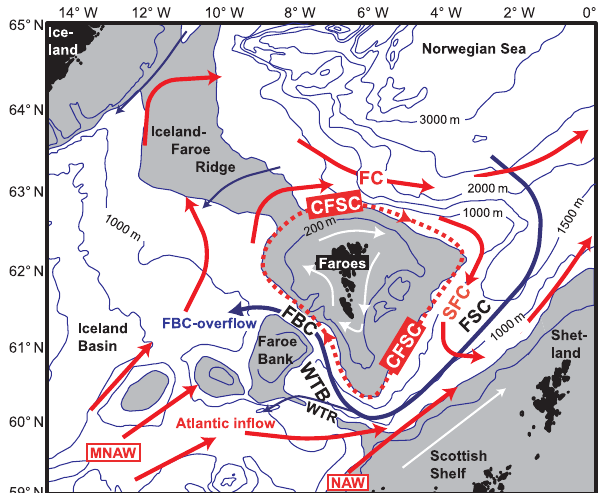
Figure 1. Bathymetry of the Faroese Channels, including schematic arrows of flow pathways. Grey areas are shallower than 500m. Con- tinuous arrows indicate well-established flows of cold overflow wa- ter at depth (blue arrows), warm Atlantic inflow as North Atlantic Water (NAW) and as Modified North Atlantic Water (MNAW) in the upper layers off the shelves (red arrows), and shelf water (white arrows). Dashed red arrows indicate the hypothetical Circum-Faroe Slope Current (CFSC). FSC, Faroe–Shetland Channel; FBC, Faroe Bank Channel; WTB, Wyville Thomson Basin; WTR, Wyville Thomson Ridge; FC, Faroe Current; SFC, Southern Faroe